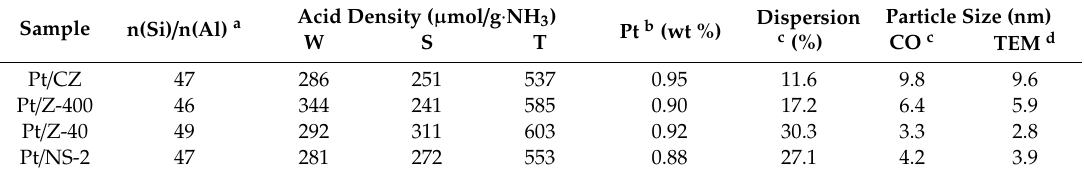
Figure 4. NH 3 –TPD profiles of di ff erent Pt-loaded zeolite catalysts. Table 1. Acidic properties and Pt distributions of various Pt